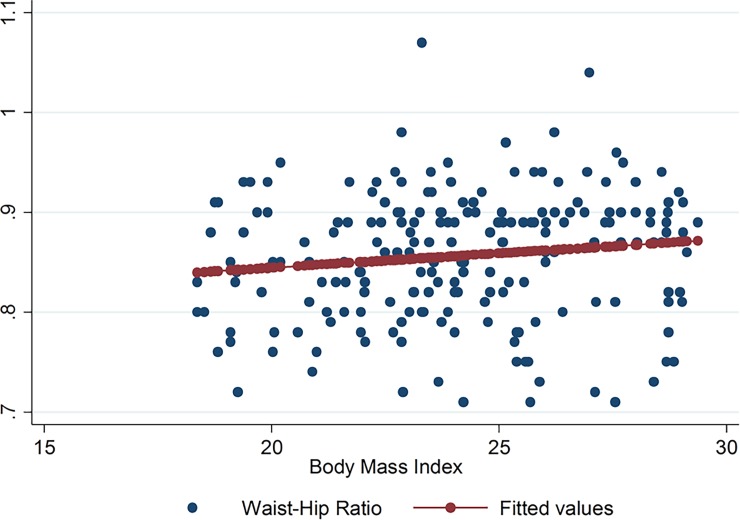
Linear regression model of the association between WHR and BMI in all study participants.